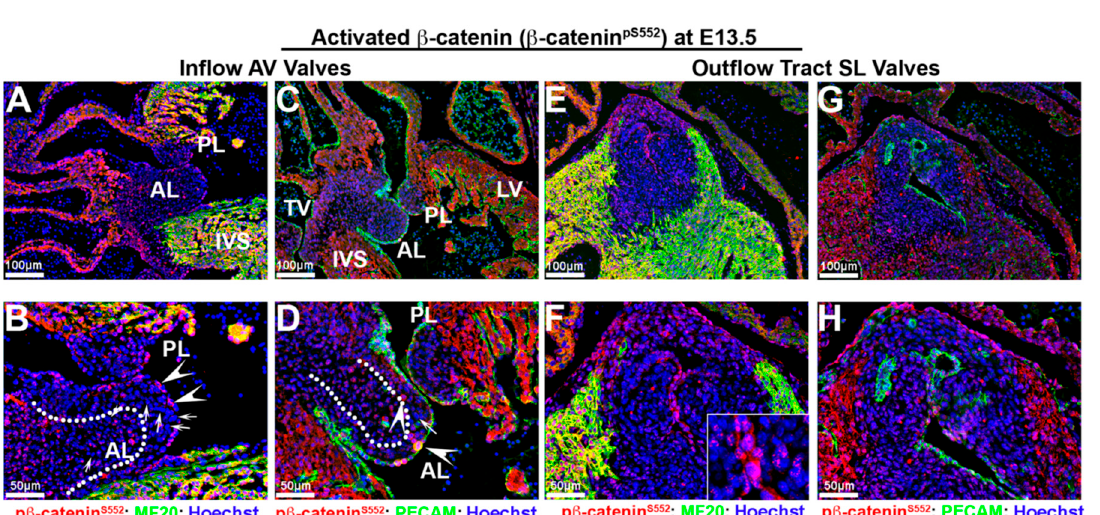
Figure 4. Activated β -catenin alters expression intensity and subcellular localization at E 13.5. ( A – D ) In atrioventricular valves, the expression of activated β -catenin (red) was reduced in valvular interstitial nuclei (( B , D )—arrows) and observed within the perinucleus and endocardial membrane (( B , D )—arrowheads). Nuclear β -catenin expression was primarily restricted to a group of cells within valve interstitial area (( B , D )—dotted line). ( E – G ). Downregulation and redistribution of activated nuclear β -catenin was also observed in the developing semilunar valves of the outflow tract. Within valve endocardial cells, activated β -catenin was present in nuclei as well as on the cell membrane (( F )—boxed region). Myocardium shared the same nucleolar and membrane β -catenin pattern as endocardium ( F , H ). AL = anterior leaflet, PL = posterior leaflet, IVS = interventricular septum, TV = tricuspid valve, SL = semilunar valves.